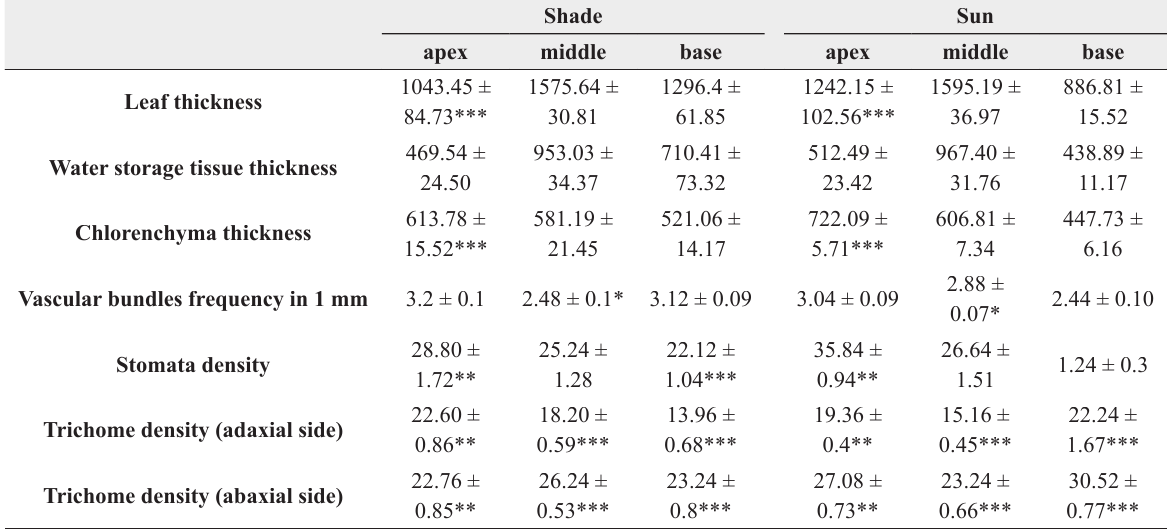
Anatomical parameters in three portions of shade and sun leaves of Neoregelia cruenta